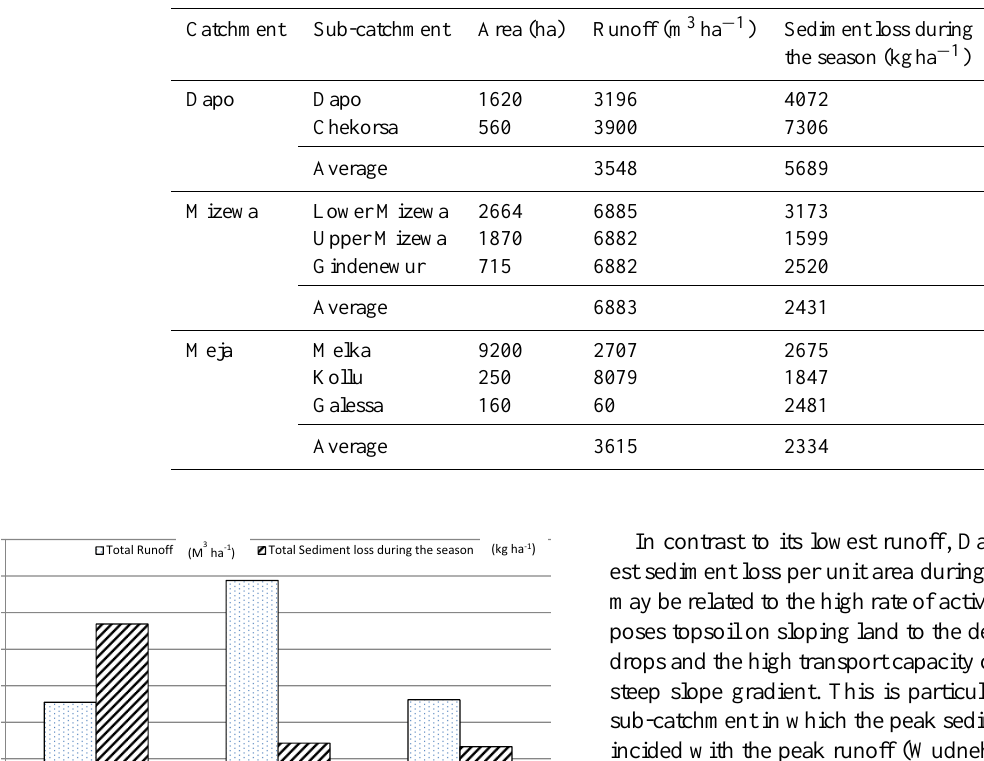
Table 4. Average runoff and sediment loss during the season from the catchments.